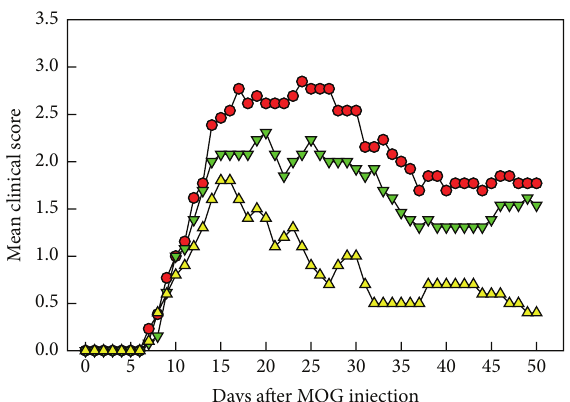
Figure 1: Effects of transplantation of F3 neural stem cells or F3.olig2 oligodendrocyte progenitor cells (1 × 10 6 cells/mouse) on day 6 on the clinical abnormalities of experimental autoimmune encephalomyelitis (EAE) mice induced by myelin oligodendrocyte glycoprotein (MOG) on day 0. Red circle: MOG alone, green reverse triangle: MOG+F3 cells, and yellow triangle: MOG+F3.olig2